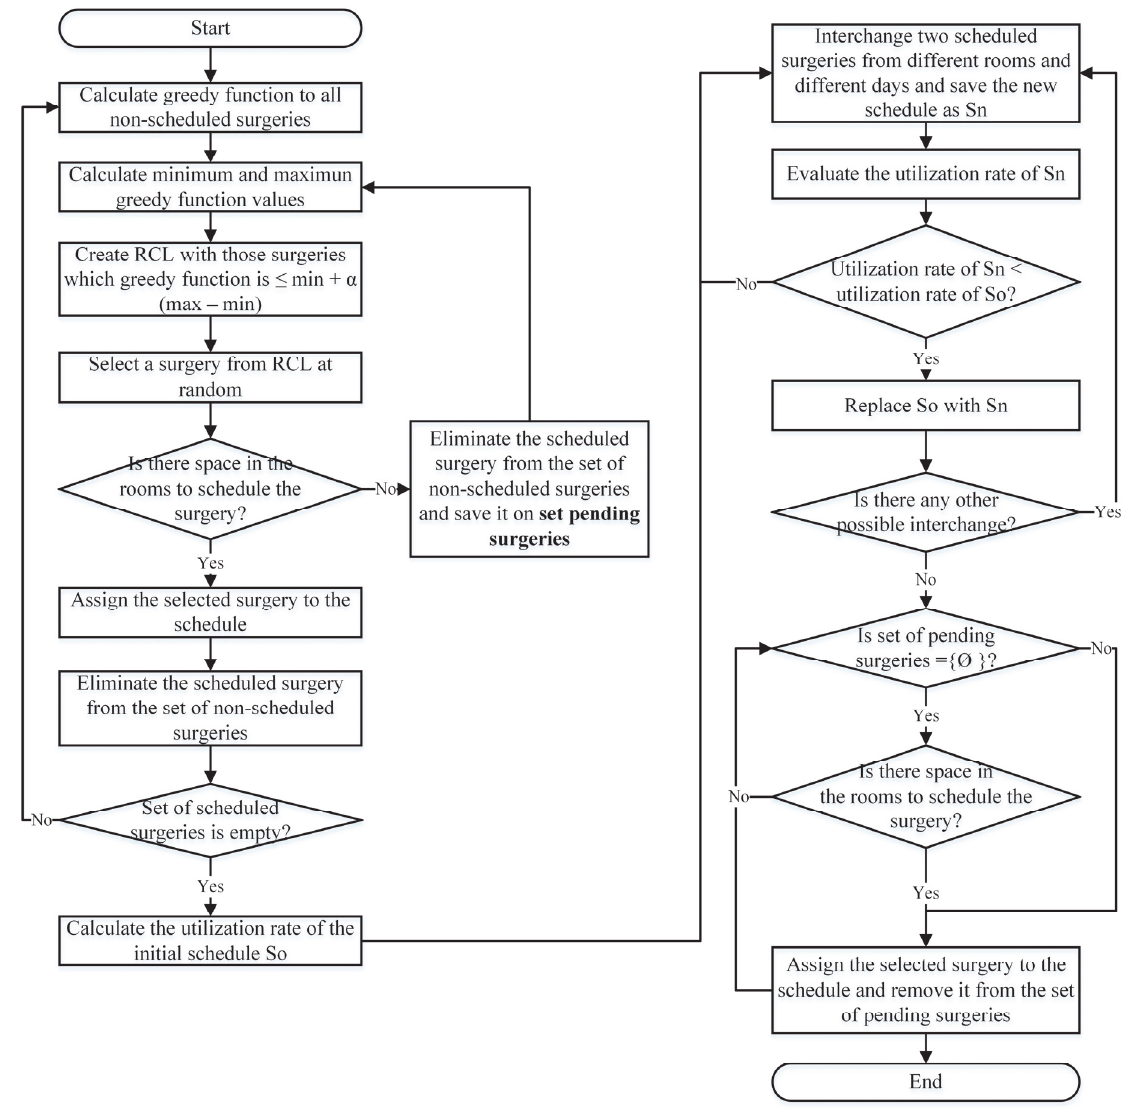
Fig. 2. Proposed GRASP